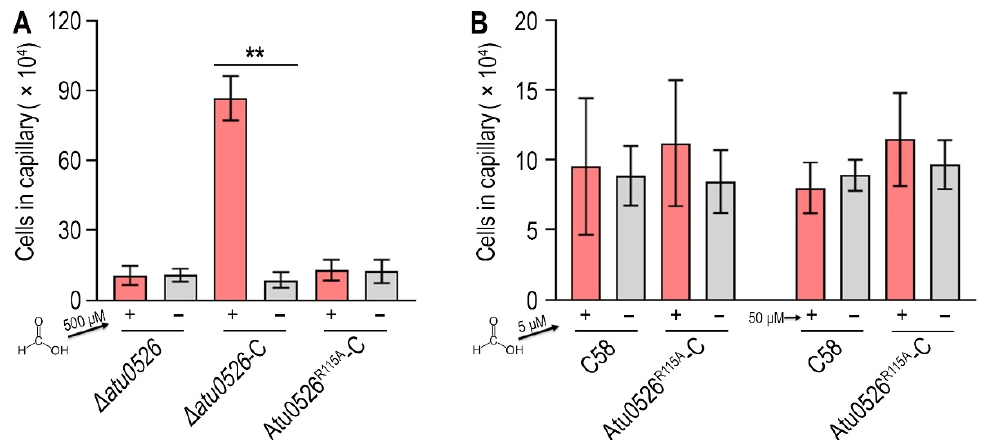
Figure 7. The effect of R115 on the chemotaxis of A. fabrum C58 toward formic acid. ( A , B ) Capillary assay of strains for formic acid. In ( A ), ∆ atu0526 , ∆ atu0526 -C and Atu0526 R115A -C were tested in capillary assay with 500 μ M formic acid. In ( B ), A. fabrum C58 and Atu0526 R115A -C were tested with 5 μ M and 50 μ M formic acid. + Represents 5, 50, or 500 μ M formic acid was applied, while − represents the case without formic acid. Data in ( A , B ) are the means of ten biological replicates with the SD. Significant differences ( p < 0.01) are indicated by **.